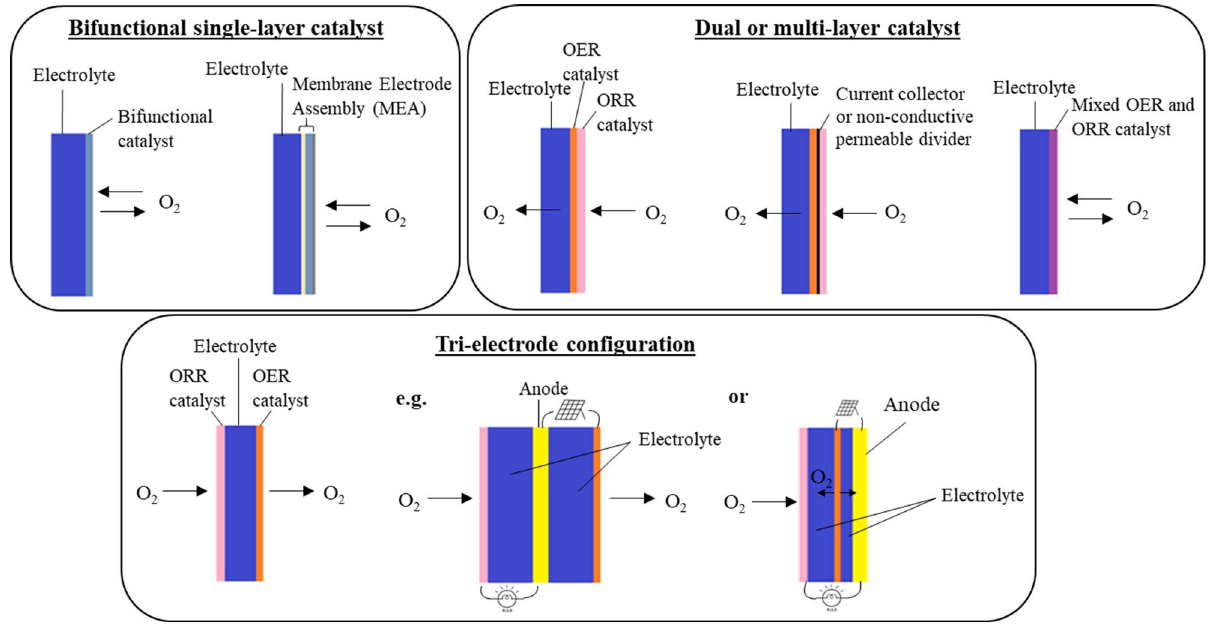
Figure. 1. Schematic illustration of oxygen electrode